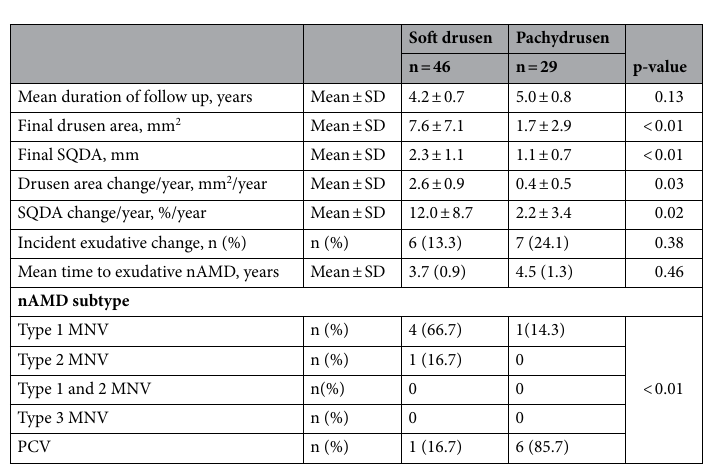
Table 2. progression characteristics of drusen subtype.